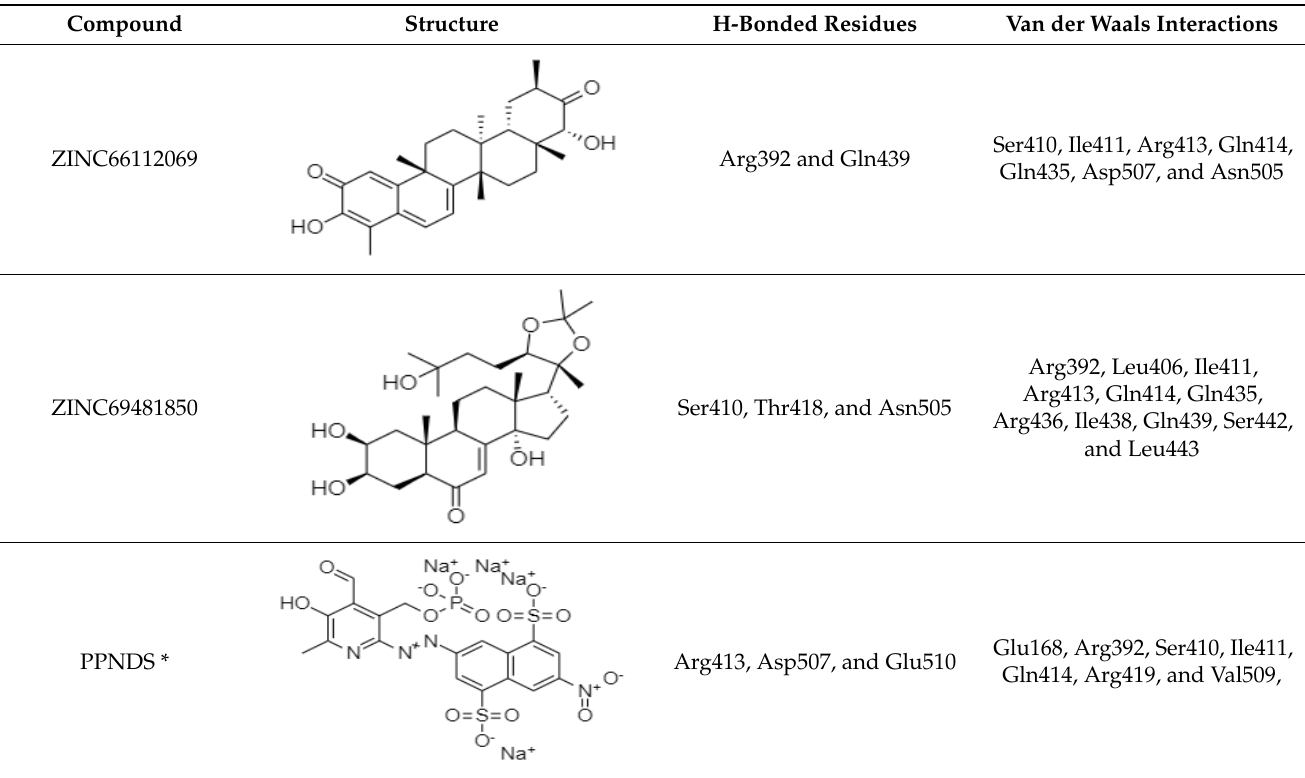
Table 3. 2D structure of hits and list of H-bonded residues of RdRp-hits complexes.